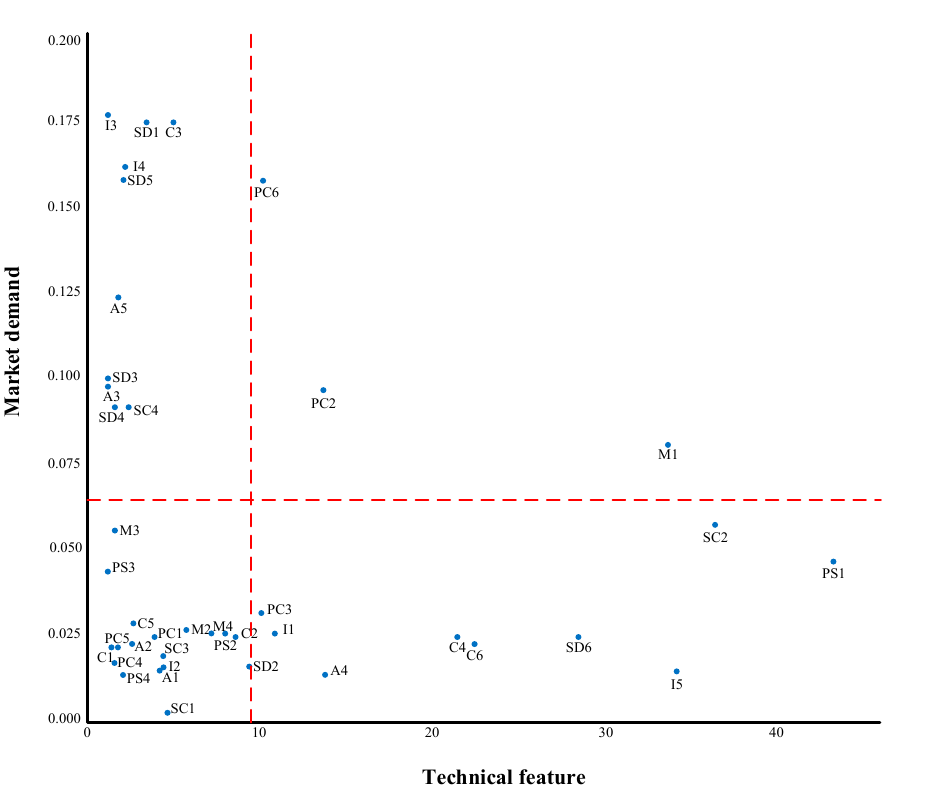
Figure 2. Portfolio map in the EVs field.